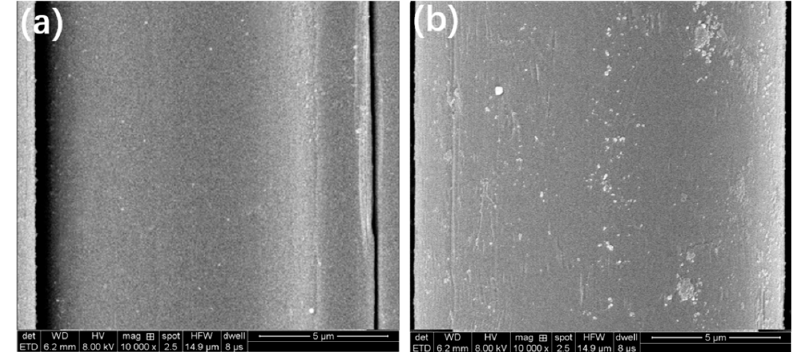
Figure 3. Scanning electron microscope (SEM) images of AF ( a ) and PAA–AF ( b ).